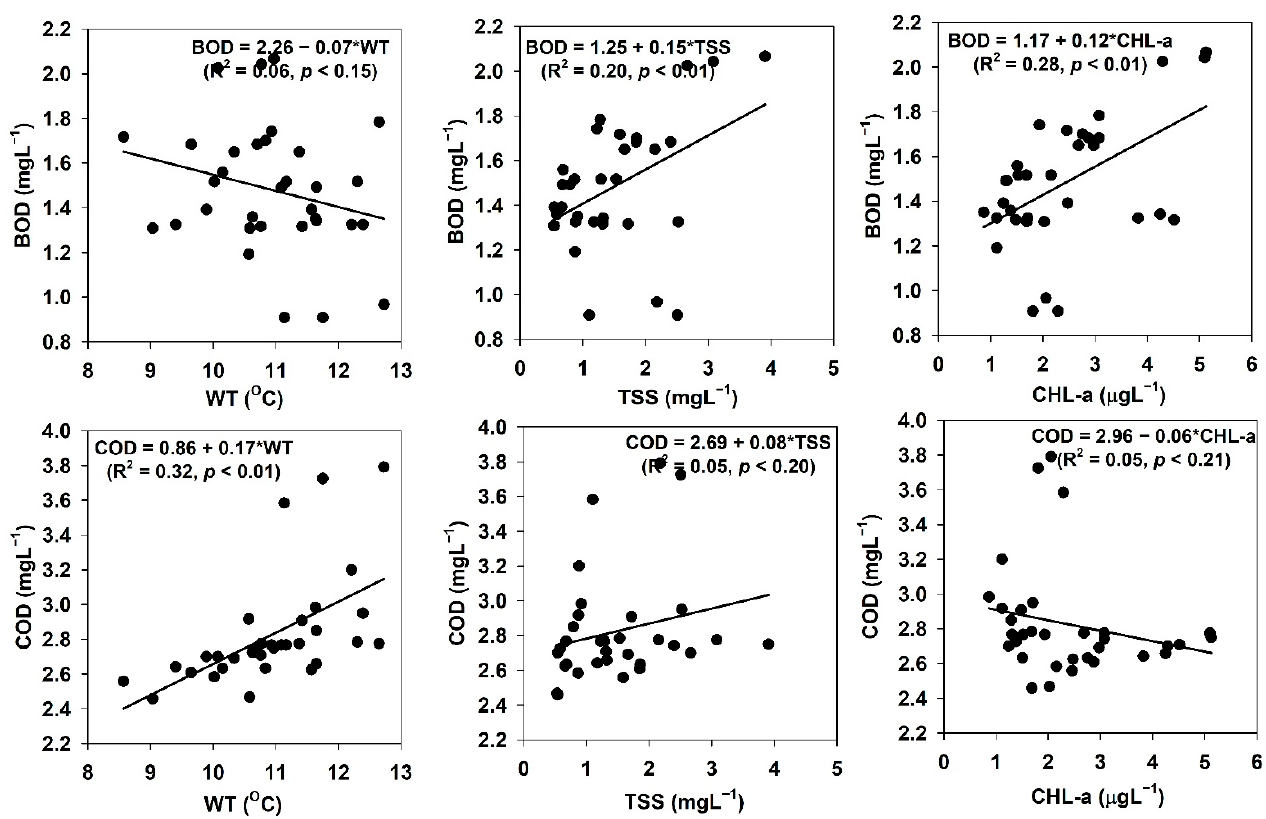
Figure 7. Relationships between biological oxygen demand (BOD) and chemical oxygen demand (COD) with water temperature (WT), total suspended solids (TSS), and chlorophyll-a (Chl-a) in Andong Reservoir.